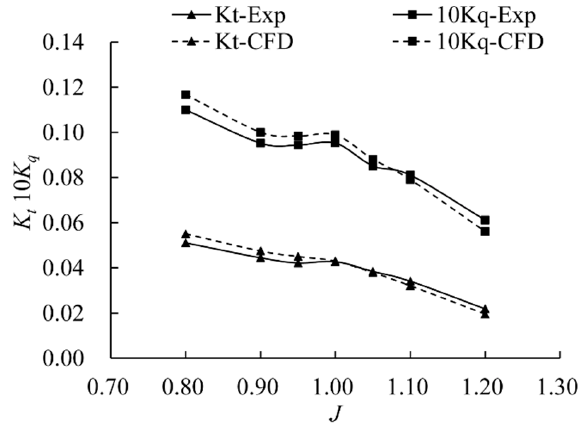
Figure 7. Comparison between the predicted and experimental data of PSP-841B.